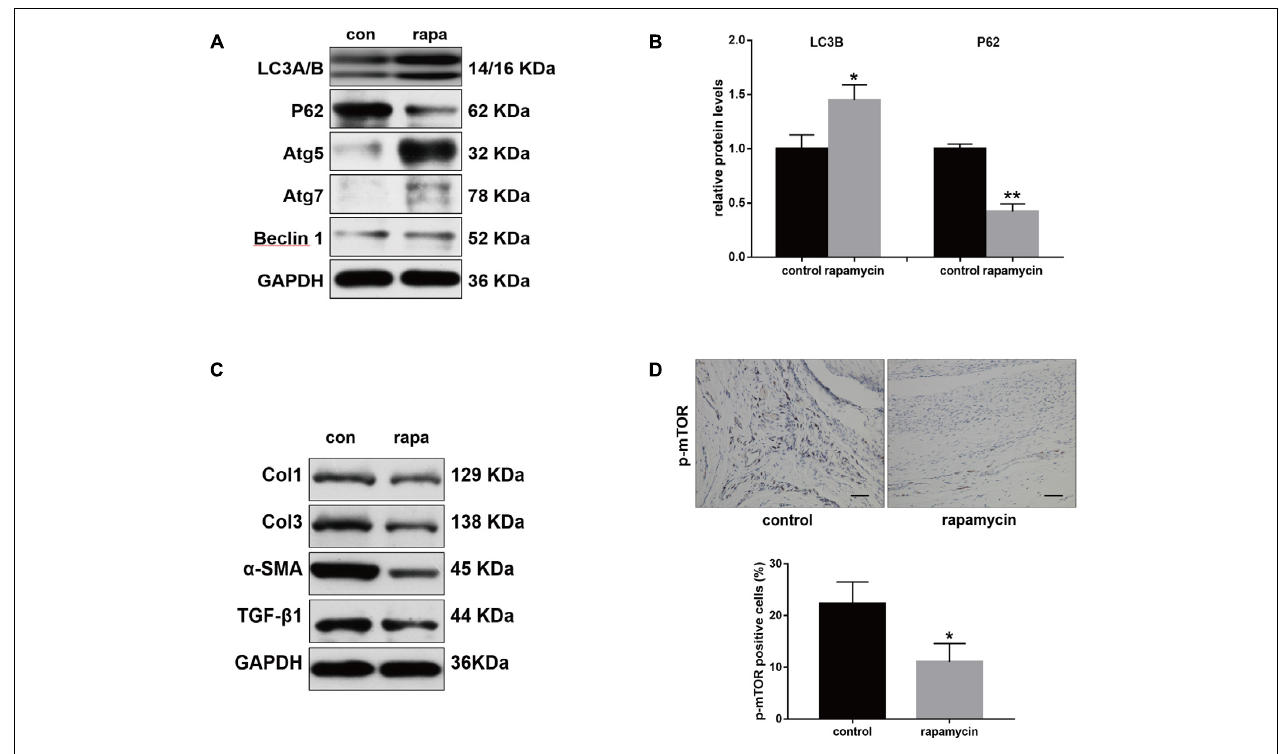
FIGURE 4 | Rapamycin regulates expression of fibrotic genes after tendon injury. (A) Representative images of western blot analysis of LC3A/B, p62, Atg5, Atg7, and Beclin 1 after different treatments. (B) Densitometry of LC3A/B and p62 expression. (C) Representative images of western blot analysis of fibrotic gene expressions after different treatments. (D) Representative images of immunohistochemical staining and quantitative analysis for p-mTOR after different treatments. Scale bar: 50 µ m. n = 5 in each group. The data are shown as the means ± SD. ∗ P < 0.05 and ∗∗ P < 0.01 compared with the control